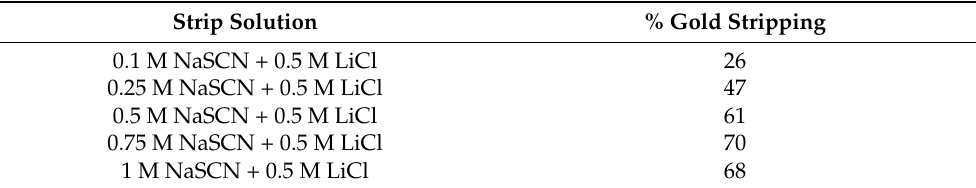
Table 8. Influence of the NaSCN concentration on gold stripping.